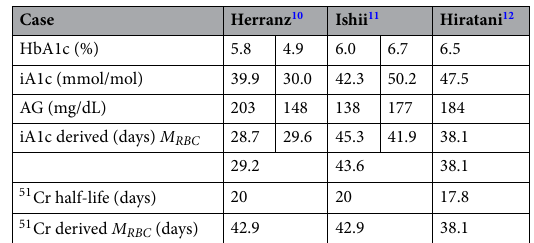
Table 4. M RBC of 3 cases in literature. HbA1c value is different from Table 2. The AG in Herranz 10 and Ishii 11 were calculated from blood glucose values using self-monitoring of blood glucose